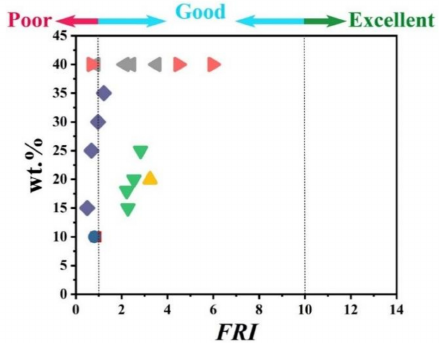
Figure 14. FRI values as a function of bio-based FR type and content. Symbols are indicative of di ff erent types of bio-based flame retardant used. Here: (cid:4) CD-10 [135], HAandCD-FR-10 [15], m-lig-20 [136], PHPI-FR-15, PHPI-FR-18, PHPI-FR-20, PHPI-FR-25 [137], BC-15, BC-25, BC-30, BC-35 [138], Wool-40, m-wool-40, m-wool-40, m-CF-40 [28], CF-40, m-CF-40, m-CF-40